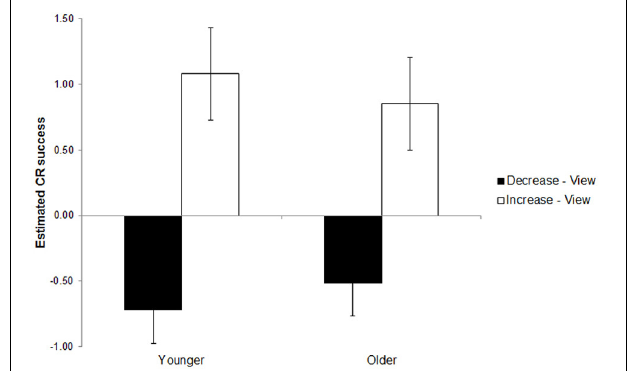
FIGURE 2 | This figure depicts success using cognitive reappraisal to decrease (black bars) and increase (white bars) emotional responding as a function of age group in the Age Group Model (see Table 3). Note that larger negative parameter estimates signal greater success for decrease vs. view whereas larger positive parameter estimates signal greater success for increase vs. view. Success scores were modestly lower in magnitude for older adults (right) than younger adults (left) but neither age difference was statistically significant. Error bars reflect the 95% confidence interval around the estimate of the age difference in cognitive reappraisal (CR)